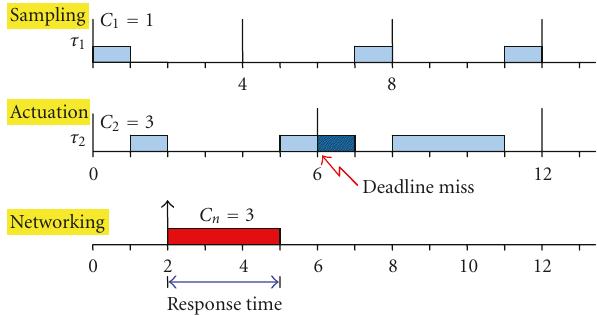
Figure 1: Activities, like sampling and actuation, are triggered periodically and executed within bounded delays. An event- triggered activity may delay them causing a system